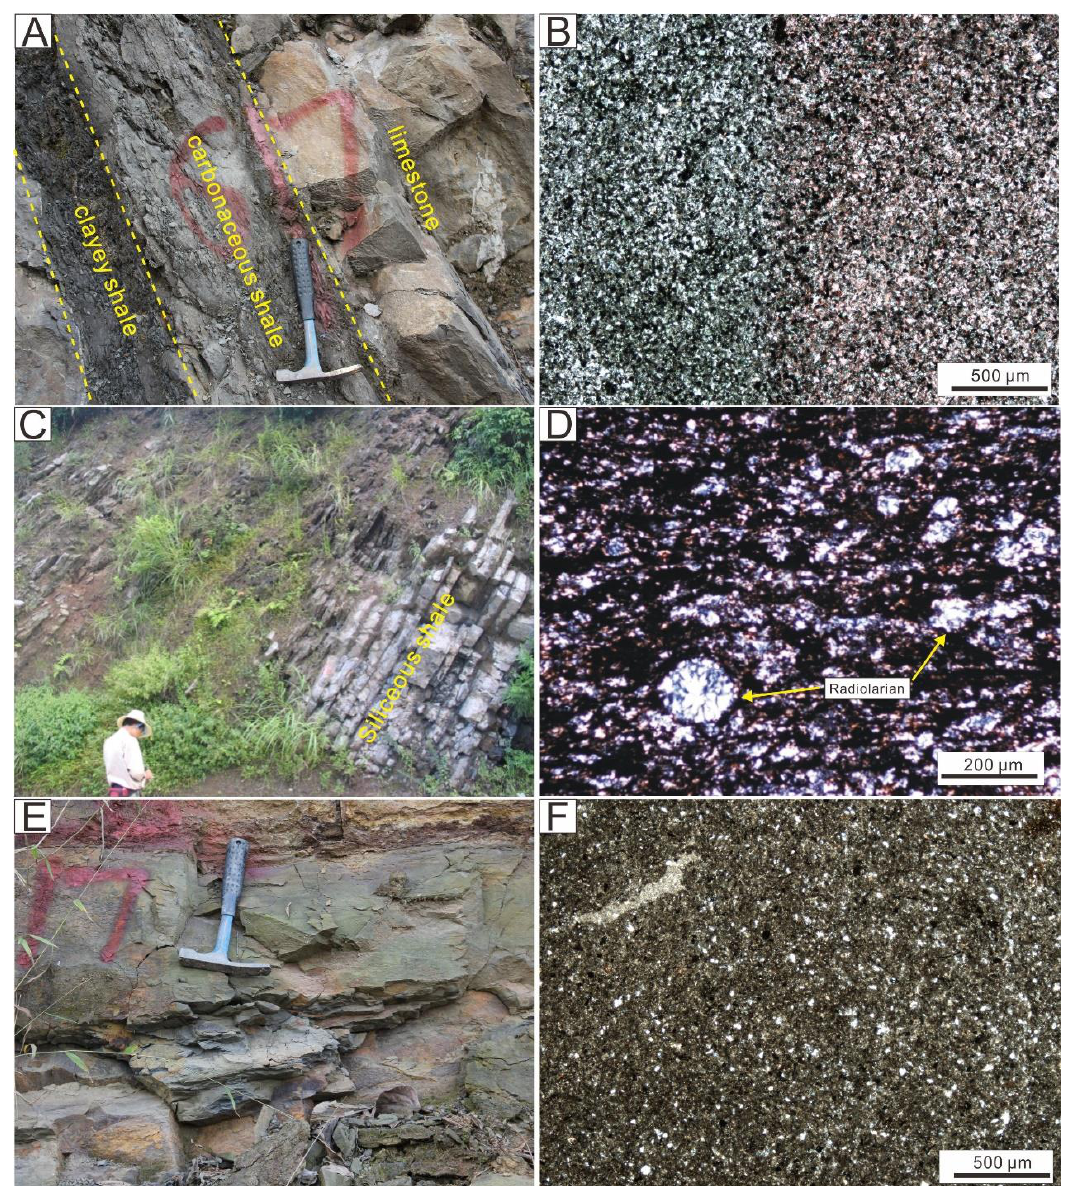
Figure 6. Characteristics of the Longtan carbonaceous shale, siliceous shale and mixed shale from field outcrops and photomicrographs. ( A ) Calcareous shale interbedded with clayey shale and limestone, Tianfu; ( B ) Microscopic characteristics of calcareous shale, stained with alizarin red, PPL, Tianfu; ( C ) siliceous shale interbedded with thinly layer limestone, Shizhu; ( D ) Silica radiolarians with black organic matter in bedded siliceous shale, Shizhu; ( E ) Thin to medium bedded mixed shale, Xinwen; ( F ) Mixed shale, lithology dominated by siltstone mudstone, PPL, Xinwen.